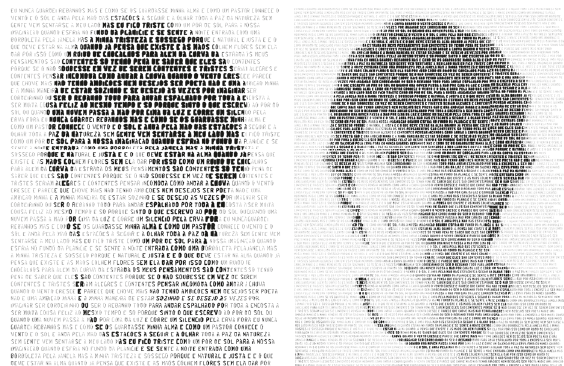
Figure 14: Typographic portraits composed of glyphs drawn with a stencil evolved with the presented framework. Two possibilities for the number of text lines are shown: 50 lines (left) and 100 lines (right). The input image is a photo of S´ergio Rebelo (graphic designer and researcher at CISUC), who tested the framework in experiment IV; and the input text is the poem “Eu Nunca Guardei Rebanhos”, written in 1914 by Alberto Caeiro, an alter ego of Fernando